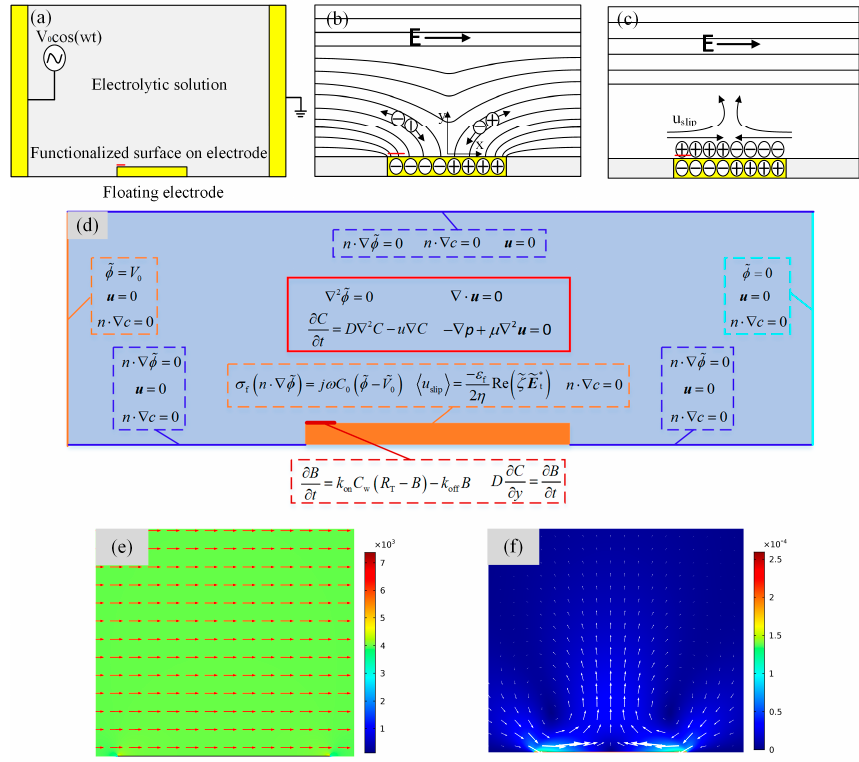
Figure 1. ( a ) Sketch of the microfluidic device geometry and electrode placement used to enhance the immunoassays in our experiment; ( b , c ) Schematic illustrations of the induced double layer and induce charge electroosmotic (ICEO) slip formation around the floating metal strip: ( b ) the counter-ionic electro-migration to the bipolar electrode following the normal field component when a sudden electric field is applied; ( c ) the formation of the dipolar diffuse screening cloud at the metal/electrolyte interface after a characteristic resistance–capacitance (RC) charging time, giving rise to the ICEO streaming flow; ( d ) the computational domain of the COMSOL simulation showing the governing equations (solid line box) and the boundary condition (dotted box); ( e ) an arrow and surface plot of electric field phasor amplitude at V 1 = 4 V and 10 Hz in the vicinity of the gate terminal (unit: V/m); ( f ) Transverse flow field of ICEO on the gate electrode with an applied voltage magnitude of 4 V and frequency of 10 Hz along the axial channel of 1000 µ m in